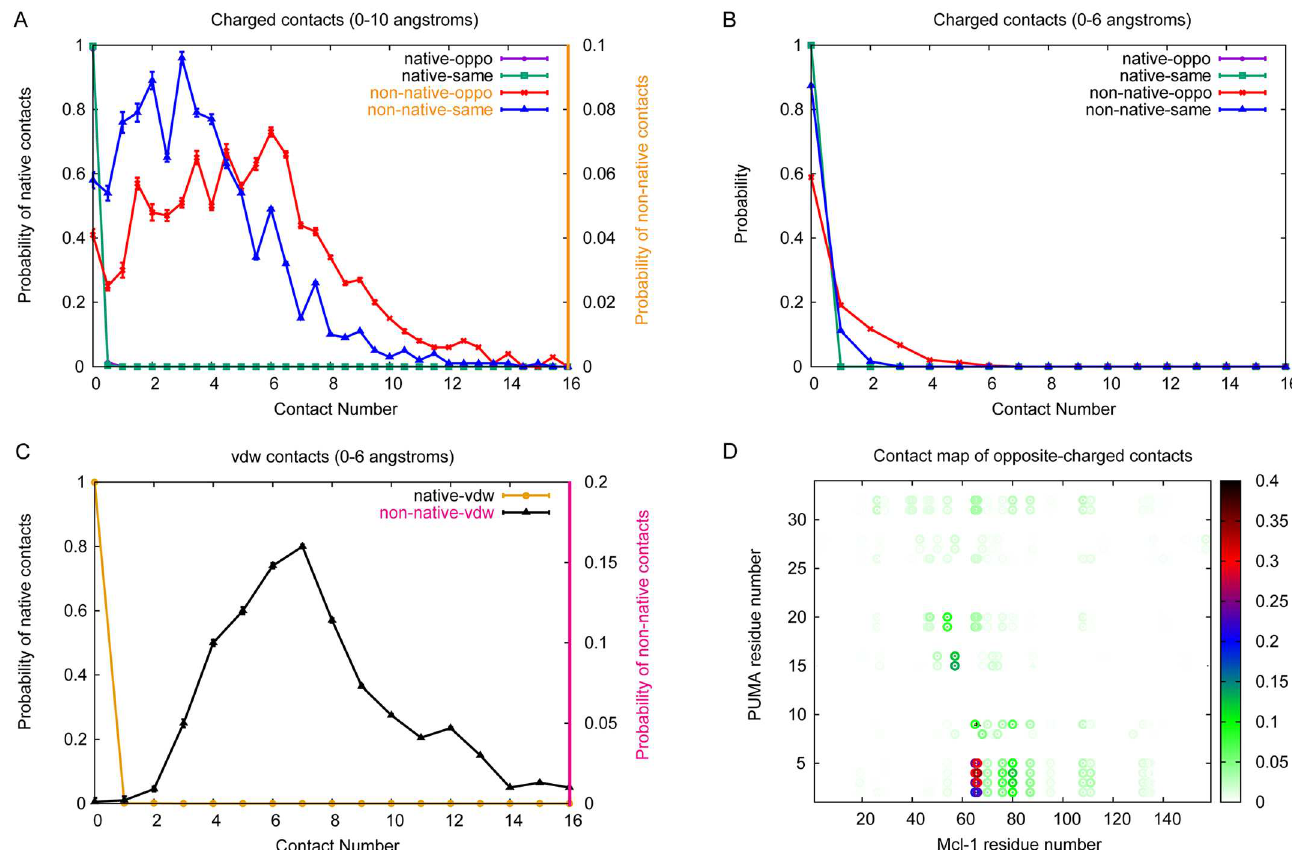
Fig 5. Contact number distribution and contact map at 10 mM ionic strength. Distributionof electrostatic and non-electrostatic interactions within the encounter complex(A-C). Contact frequencies for variousinteractiontypes within encountercomplex (at 10 mM ionic strength). Standard errors of data are shown. (D) Observed opposite-chargedcontacts within encountercomplex(at 10 mM ionic strength). Encounter complex structures were definedaccordingto Huang et al. [41]. Native contacts are illustratedas triangles, non-nativecontacts are illustratedas circles.